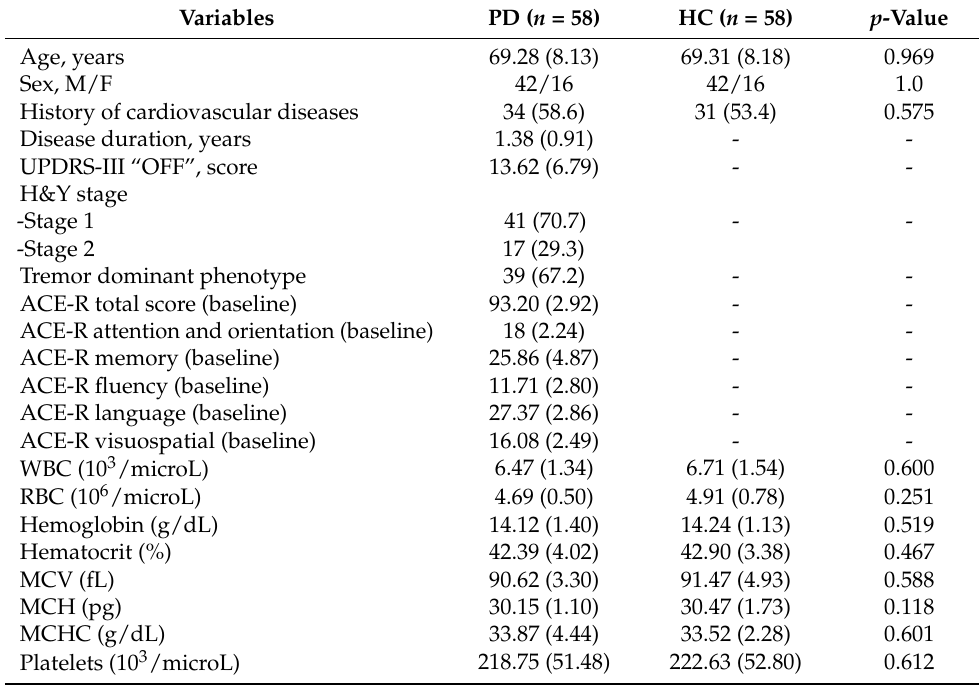
Table 1. Demographic, clinical, and immunological characteristics of PD patients and healthy controls.